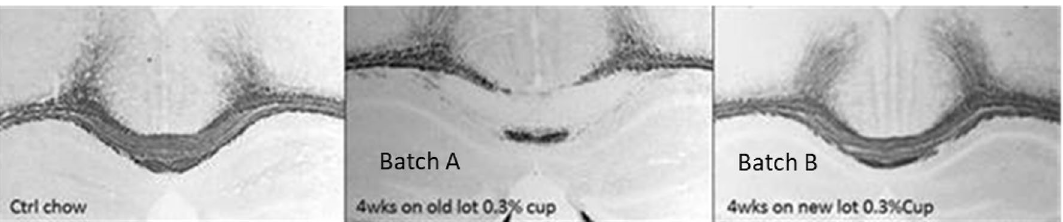
Figure 3. Demyelination detected in corpus callosum by black gold staining: the mouse on the left is on control chow, the middle mouse shows great demyelination of the corpus callosum using the batch A chow, and the mouse on the right was from the mouse using the batch B